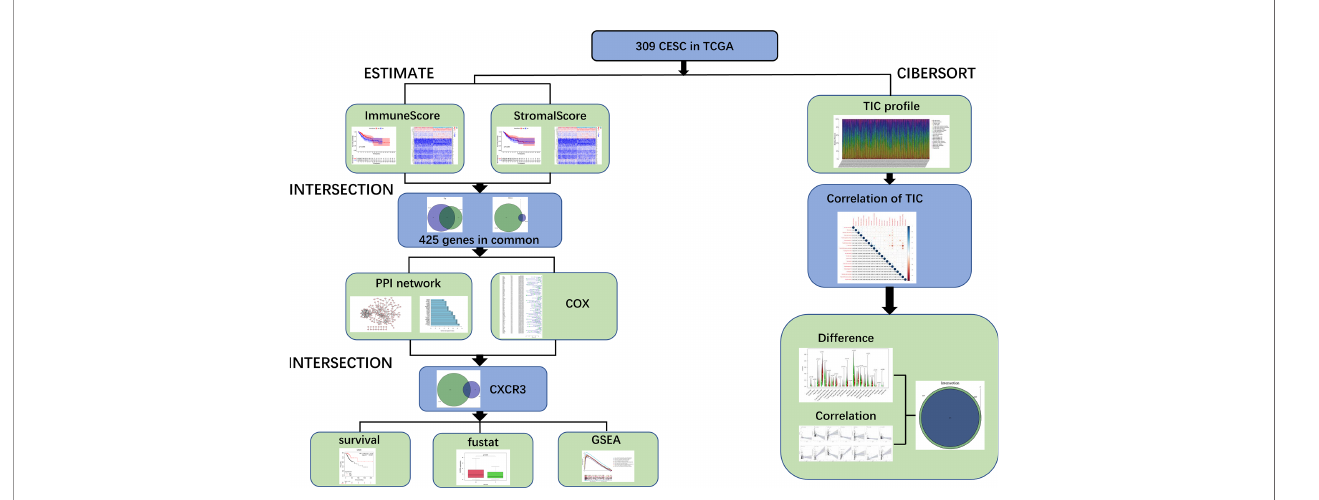
FIGURE 1 | Analysis work fl ow of this